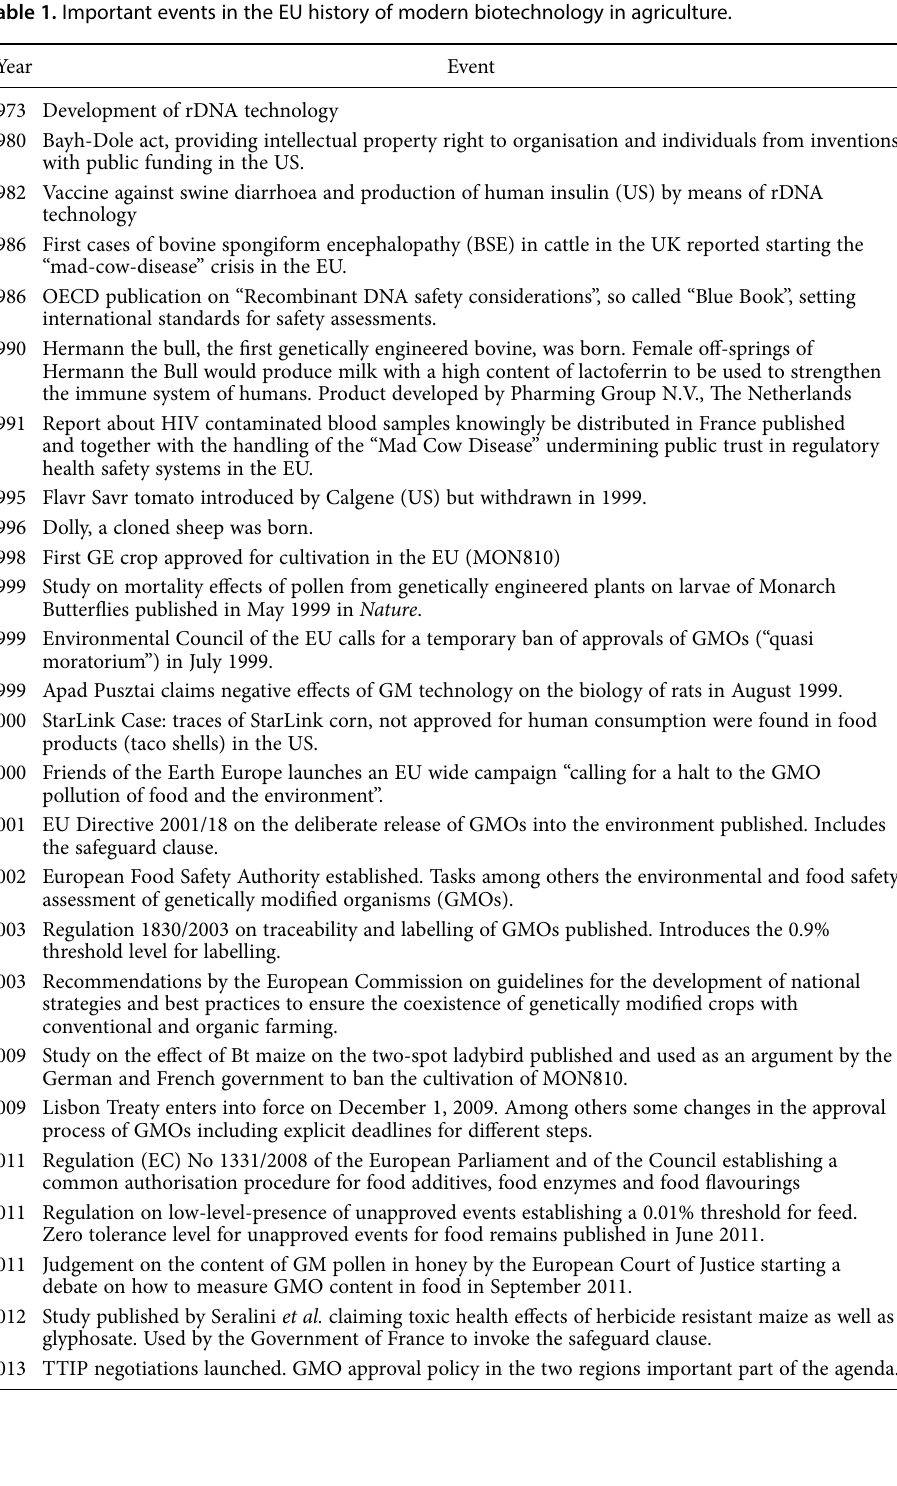
Table 1. Important events in the EU history of modern biotechnology in